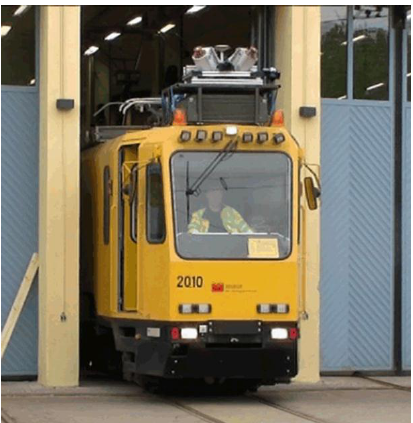
Figure 4: StreetMapper sensor assembly mounted on a tram in Helsinki 2.1 Navigation System